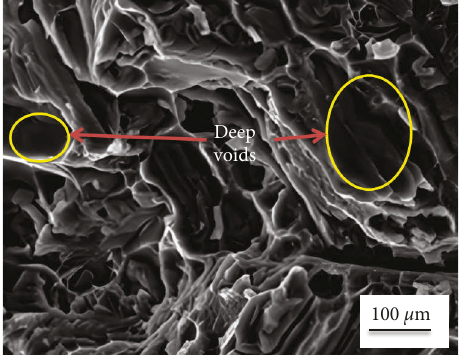
Figure 13: SEM fracture image of sample-L1 (S1-T2, -R4-P1).